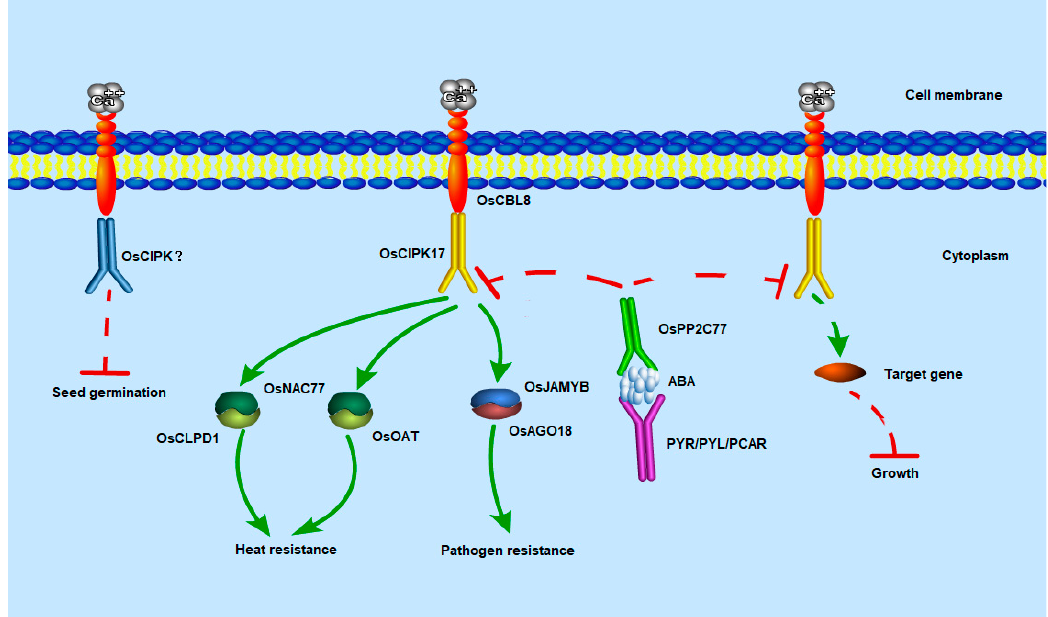
Figure 9. Potential regulatory mechanism of the OsCBL8-OsCIPK17 module. Calcium signaling be- gins with OsCBL8, which is located in the cell membrane, binds to calcium and then enforces Os- CIPK17 and binds to it. OsCIPK17 may further regulate the growth and development of seedlings